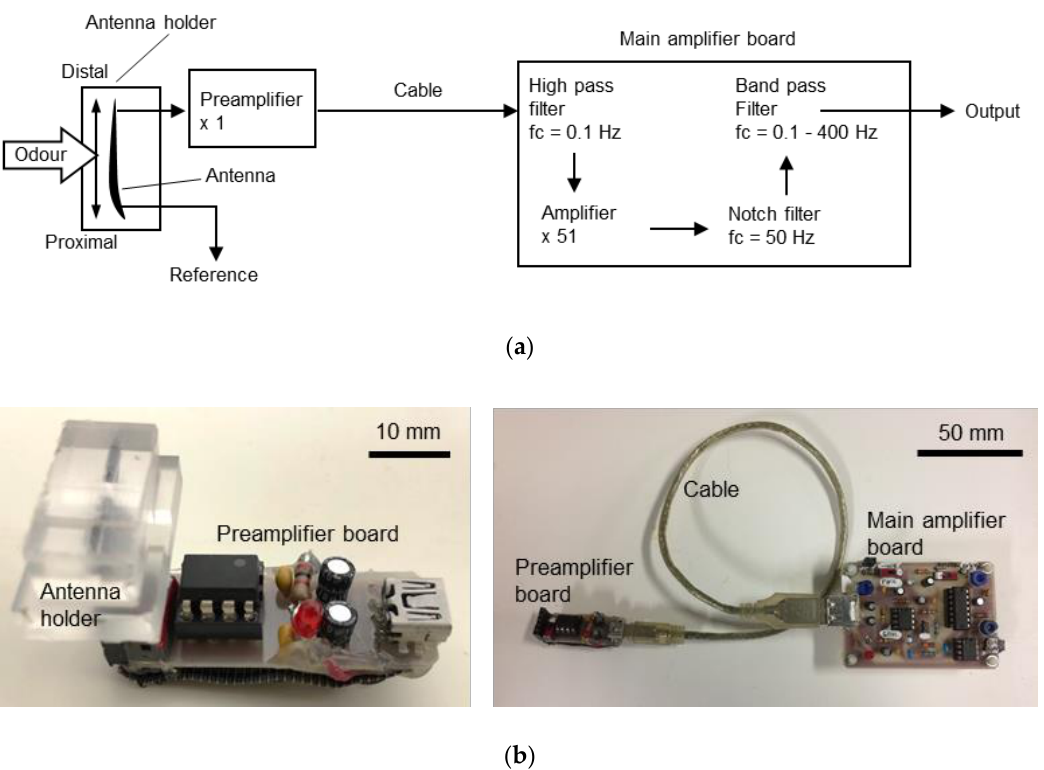
Figure 2. Custom-built electroantennogram (EAG) amplifier. ( a ) Schematic of the amplifier. ( b ) The antenna holder attached to the preamplifier board (left) and amplifier boards (right).